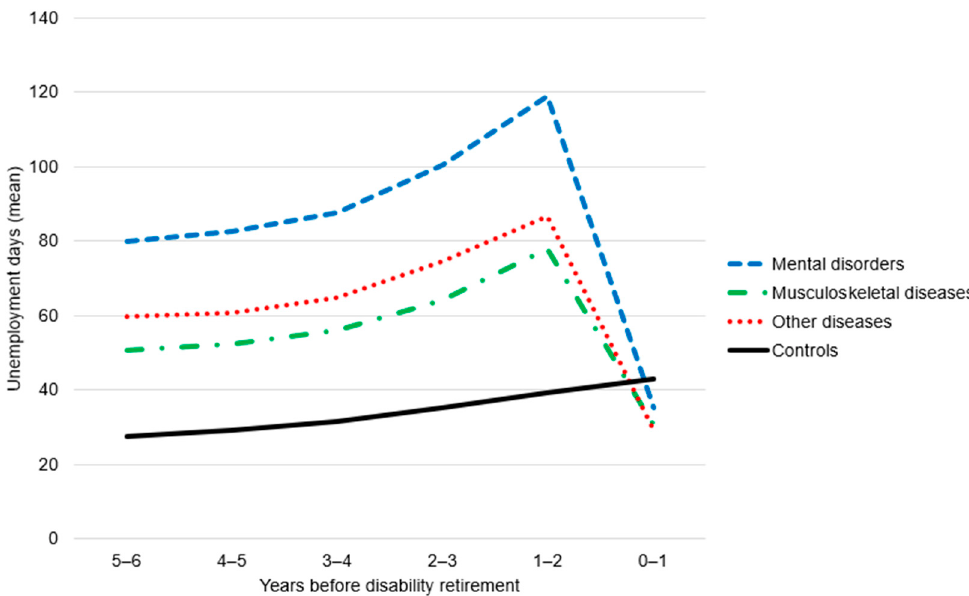
Figure 1. Annual number of unemployment days (mean) during the six years preceding disability retirement among disability retirees in the three diagnostic groups and their age- and gender-matched control.